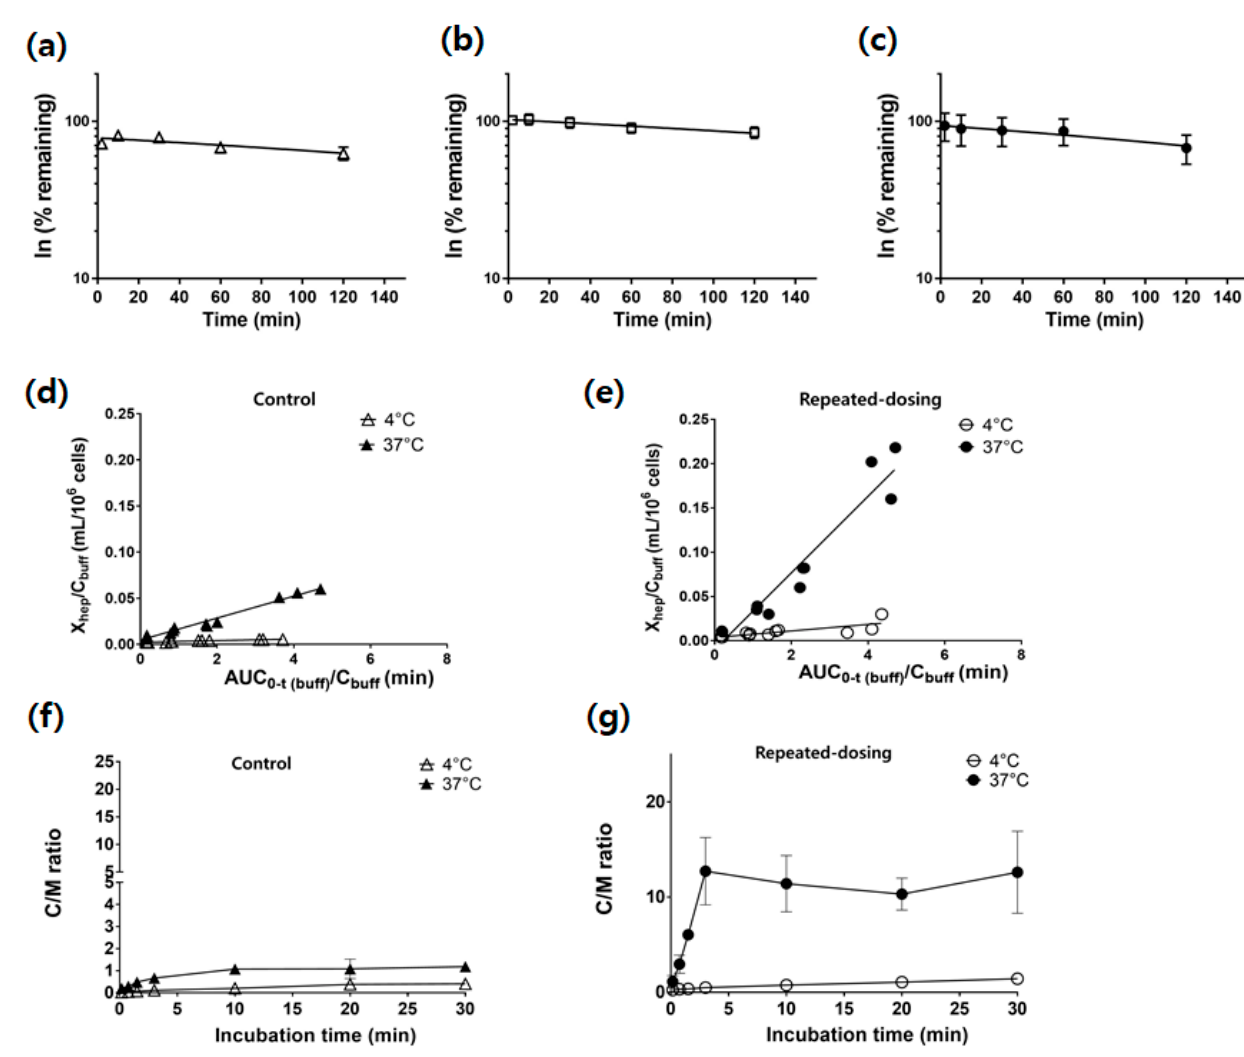
Figure 5. ( a – c ) The degradation rate of SCR430 in the suspended hepatocytes from the three groups of rats: control ( a ), vehicle ( b ), and repeated-dosing ( c ) groups. ( d , e ) Integration plots for the hepatic uptake clearance of SCR430 in the control ( d ) and repeated-dosing ( e ) groups at the condition of 4 ◦ C (open) and 37 ◦ C (close). The amount of SCR430 within the hepatocytes divided by the concentration (t) in the buffer was plotted against the AUC 0– ∞ (buff) divided by the concentration (t) in the buffer. The solid lines represent the linear regression line for the control and repeated-dosing groups. ( f , g ) The Kp (C/M ratio) of SCR430 was assessed at 4 ◦ C (open) and 37 ◦ C (close) to determine the Kp uu,ss in the control ( f ) and repeated-dosing groups ( g ) (Data = mean ±